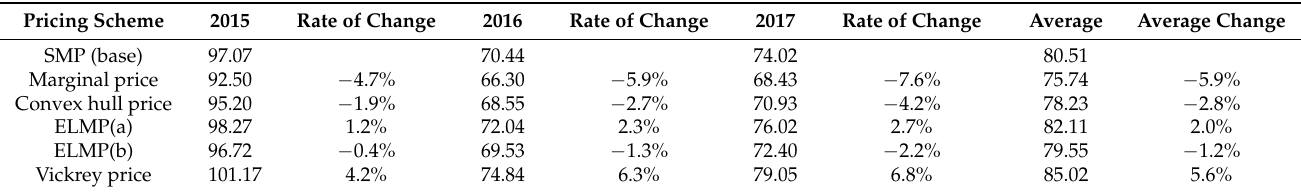
Table 3. Comparison of annual demand-weighted average market price (KRW/kWh 1 ).